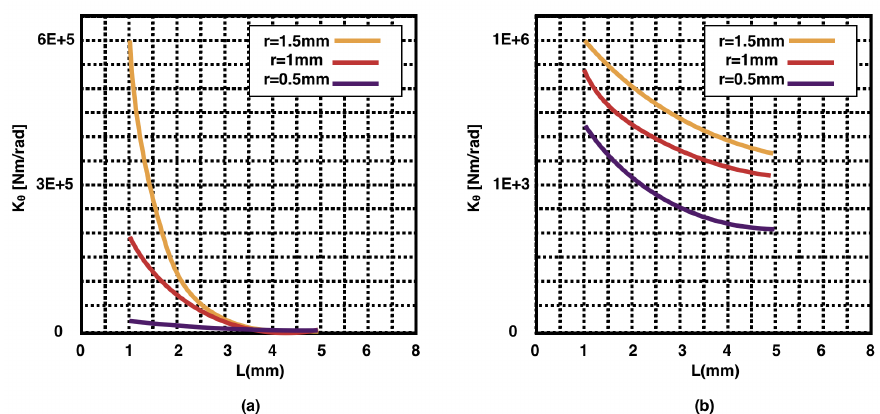
Figure 5. ( a ) Variation of torsional stiffness with clutch length, ( b ) Variation of torsional stiffness with clutch length,